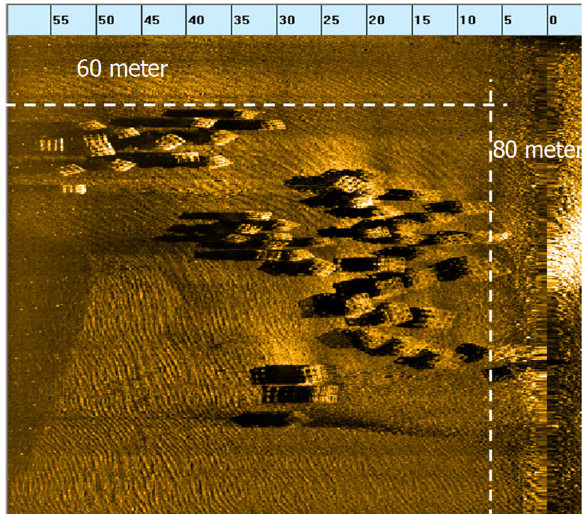
Figure 6. Measurement of distribution areas of the AR modules. The sonar images were mosaicked to analyze the overall condition of the study area.